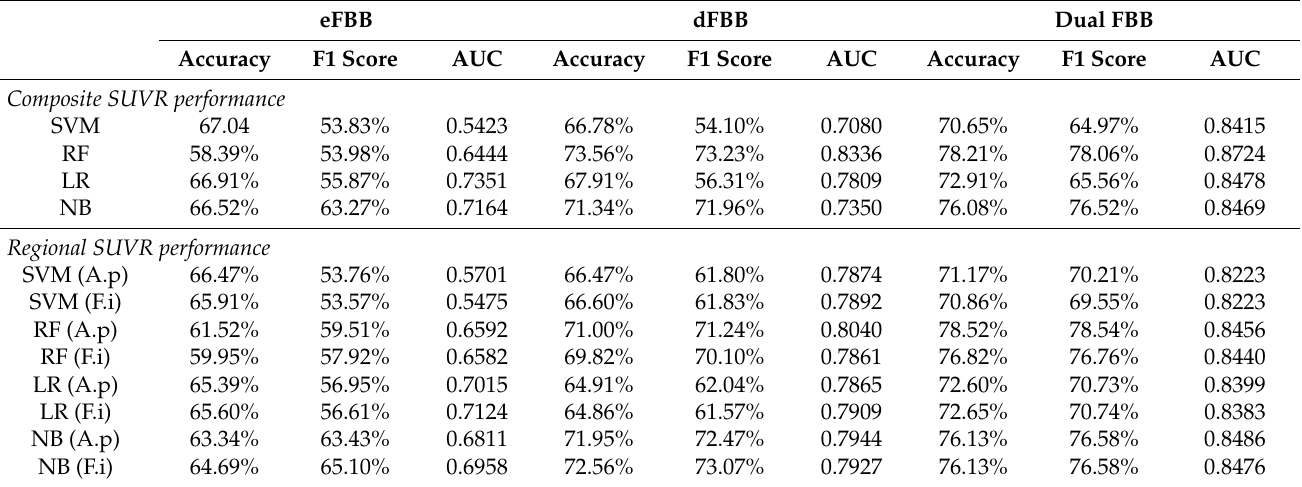
Table 2. Comparison of classification performance of models according to each phase of FBB. eFBB dFBB Dual